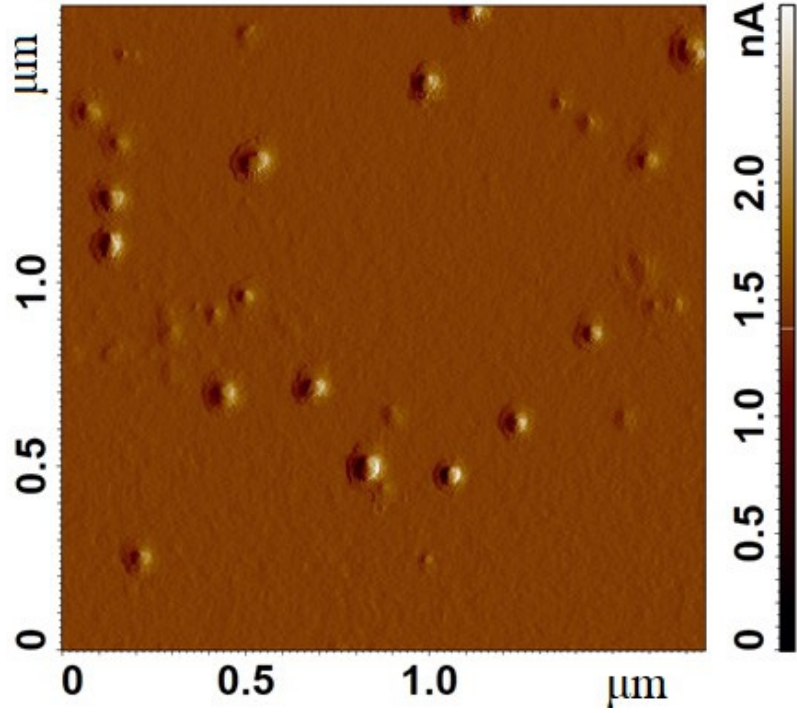
Figure 1. ( a ) The scheme of synthesis of grafted chitosans. m = 5—percentage of acylated pyranose fragments, n = 95—percentage of deacylated pyranose fragments, and a—experimental modification degree. ( b ) Fluorescent image of Chit5-OA-20 micelles and their aggregates, labeled with doxorubicin. ( c ) Atomic force microscopy images of Chit5. ( d ) Atomic force microscopy images of Chit5-MUA-20. ( e ) Magnitude signal image of the same area as ( d ).